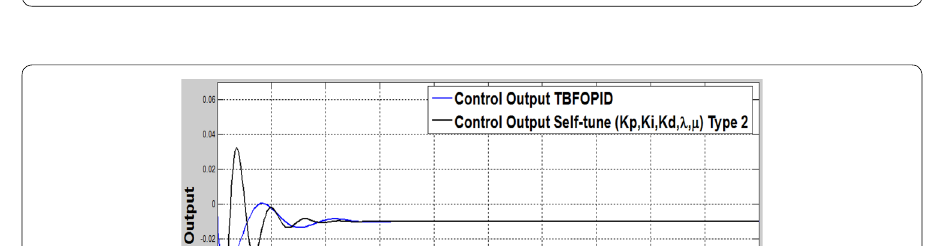
Fig. 24 Response of Δ F via IT2FST ( k p , k i , k d , λ and μ )